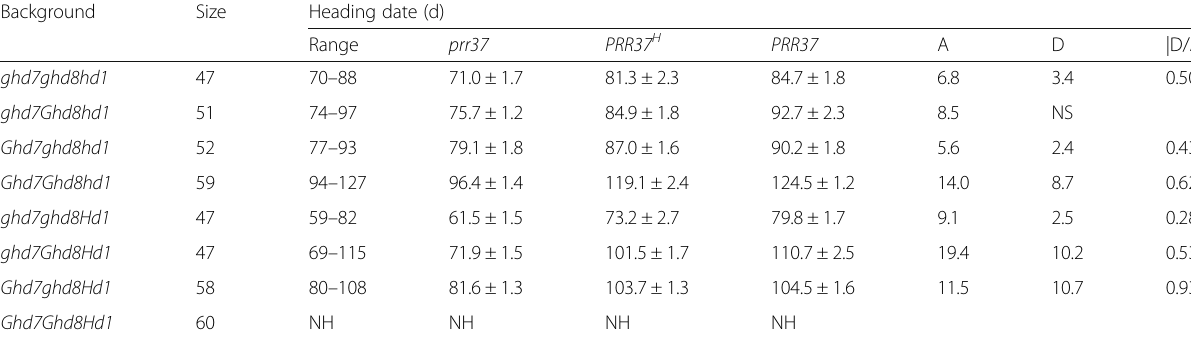
Size, the number of plants of segregating population; PRR37 H , heterozygous allele of PRR37 ; A, additive effect; D, dominance effect; |D/A|, the degree of dominance; NS, no significance; NH, no